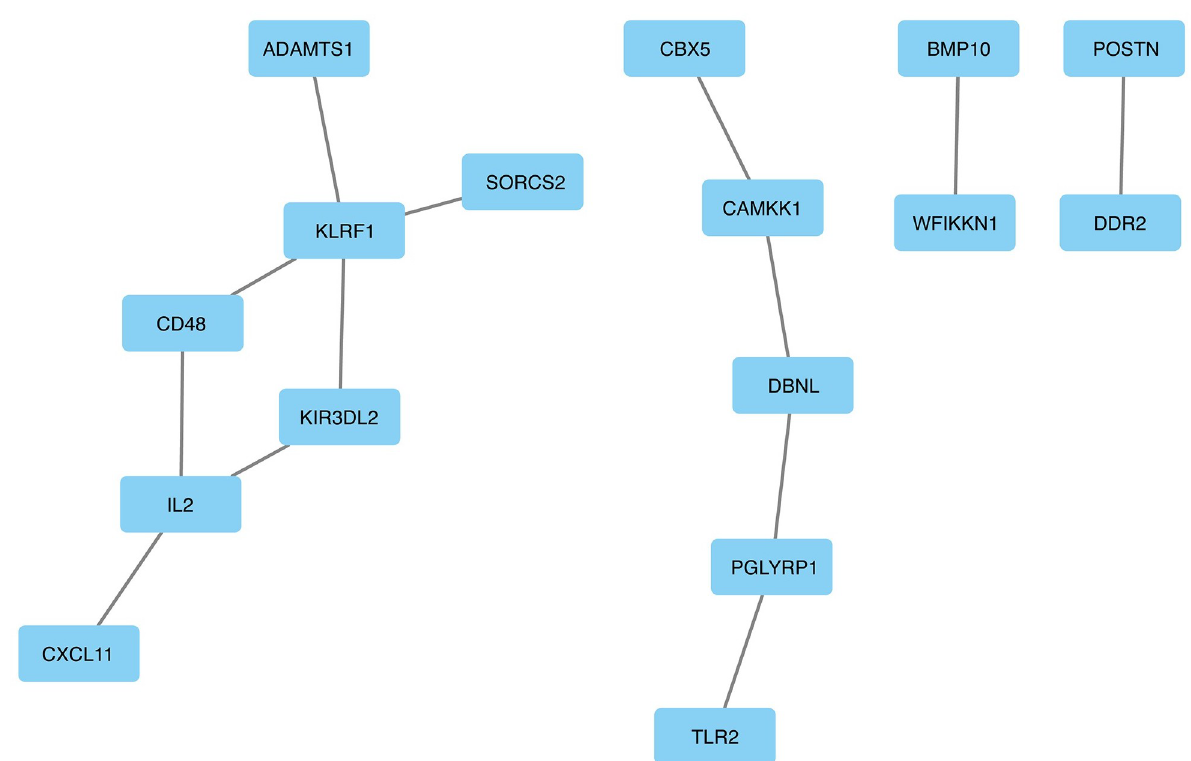
Fig 7. Important subnetworks for COPD prediction. Top important genes/proteins are identified with SHAP values. The sub-adjacency matrix of the top 30 important genes/proteins is extracted for plotting. The genes/proteins without any connections are removed.